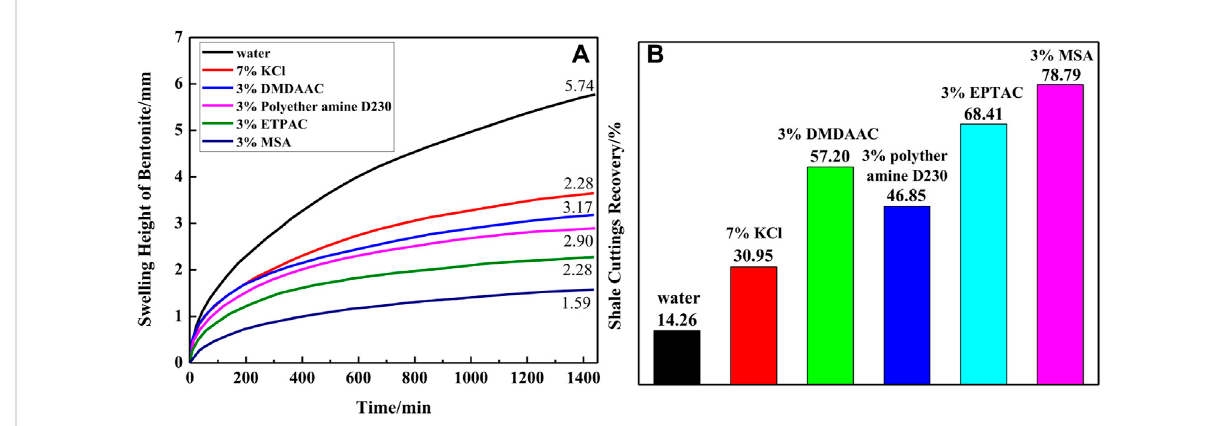
FIGURE 10 Swelling height of bentonite (A) and shale cuttings recovery (B) in different aqueous solutions.